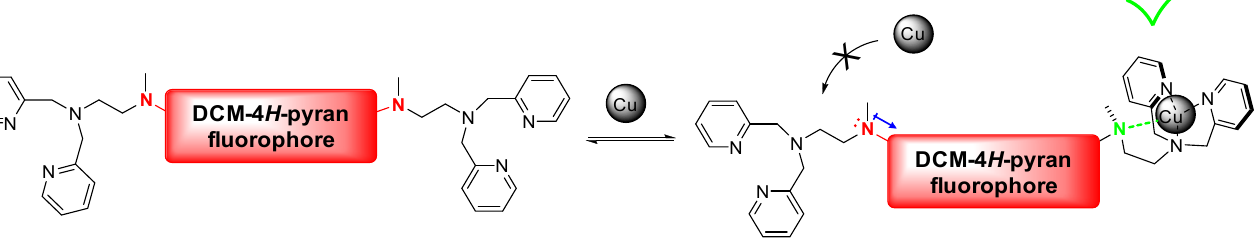
Figure 5. Possible binding mode of copper to 4 . The coordination of the metal includes the nitrogen that is directly coupled to the fluorophore (shown in green), causing a blue-shift in the absorption maximum. The lone pair from the symmetric nitrogen (shown in red) is no longer available for binding a second copper. Indeed, the experimental data from fluorescence measurements fit well to a 1:1 binding stoichiometry, yielding an association constant of 7.45×10 7 M − 1 , which is at least one order of magnitude higher when compared to other similar systems [8,10,12-14]. To confirm the stoichiometry, we used the method of continuous variations and obtained the corresponding Job’s plot (Figure 6B) [31]. The maximum was observed for a value of 0.52 on the molar fraction of sensor 4 , which indicates a 1:1 binding model. The limit of